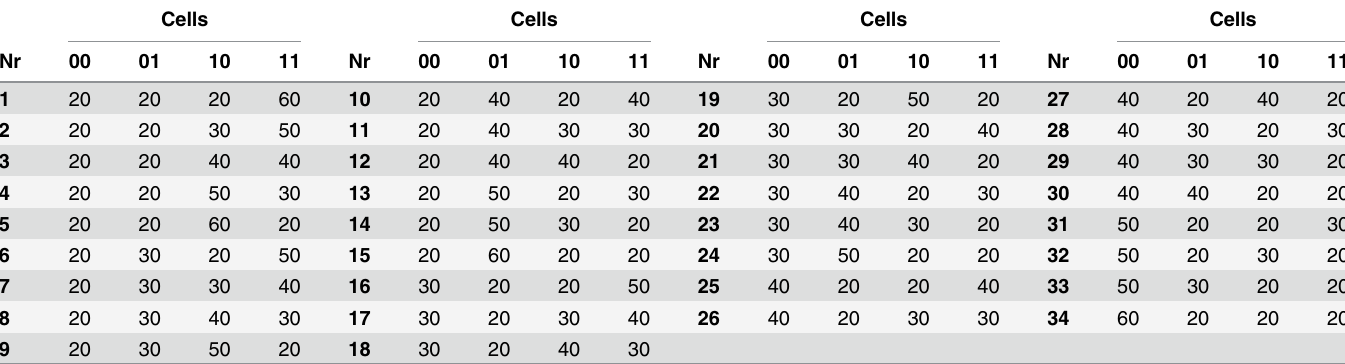
Table 1. Systematic variations of 34 unbalanced 2 x 2 designs with 120 subjects.